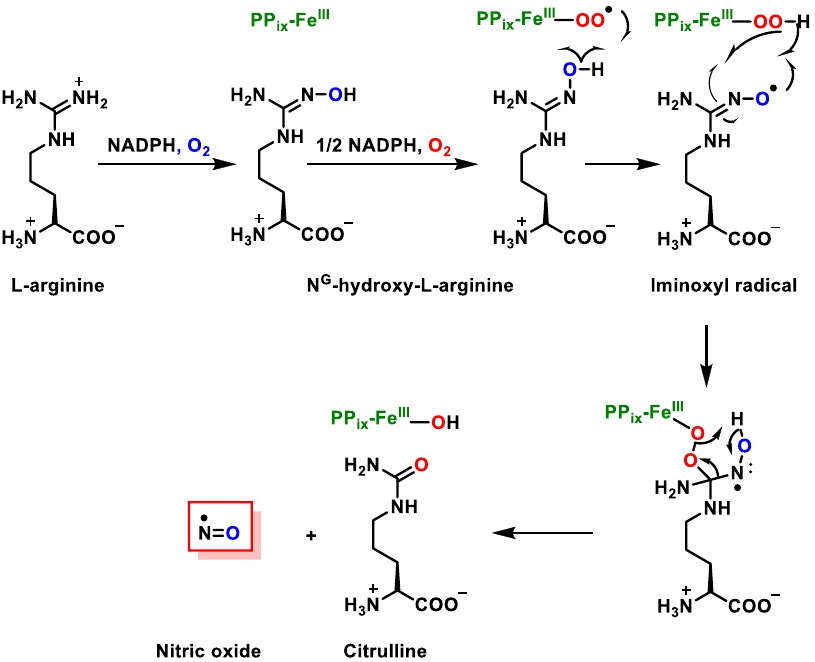
Figure 1. Synthesis of citrulline and • NO from L-arginine, in a reaction catalysed by the enzyme NOS.